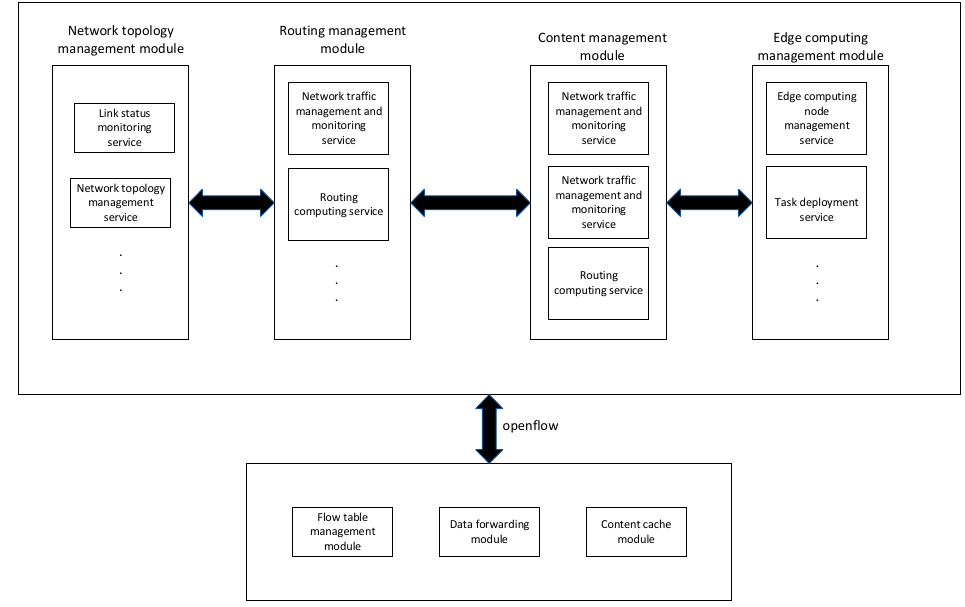
Figure 4. SDN/ICN architecture design.